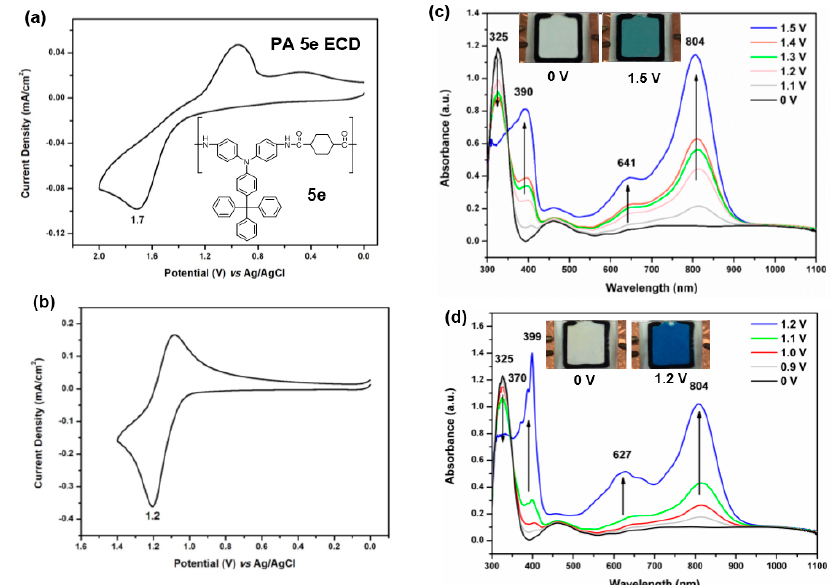
Figure 11. ( a ) Cyclic voltammetry (CV) diagram of the Electrochromic Devices (ECD) (ITO/PA 5e film/gel electrolyte/ITO) based on the cast film (thickness: 250 ± 30 nm) of PA 5e on the ITO-coated glass substrate; ( b ) CV diagram of the ECD based on PA 5e /HV; ( c ) Spectra and color change of the ECD based on PA 5e at indicated applied voltages; ( d ) Spectra and color change of the PA 5e /HV ECD at indicated applied voltages. The semi-gelled electrolyte consists of 10-wt % PMMA (average M w = 120,000) in 0.6 M LiBF 4 /propylene carbonate.